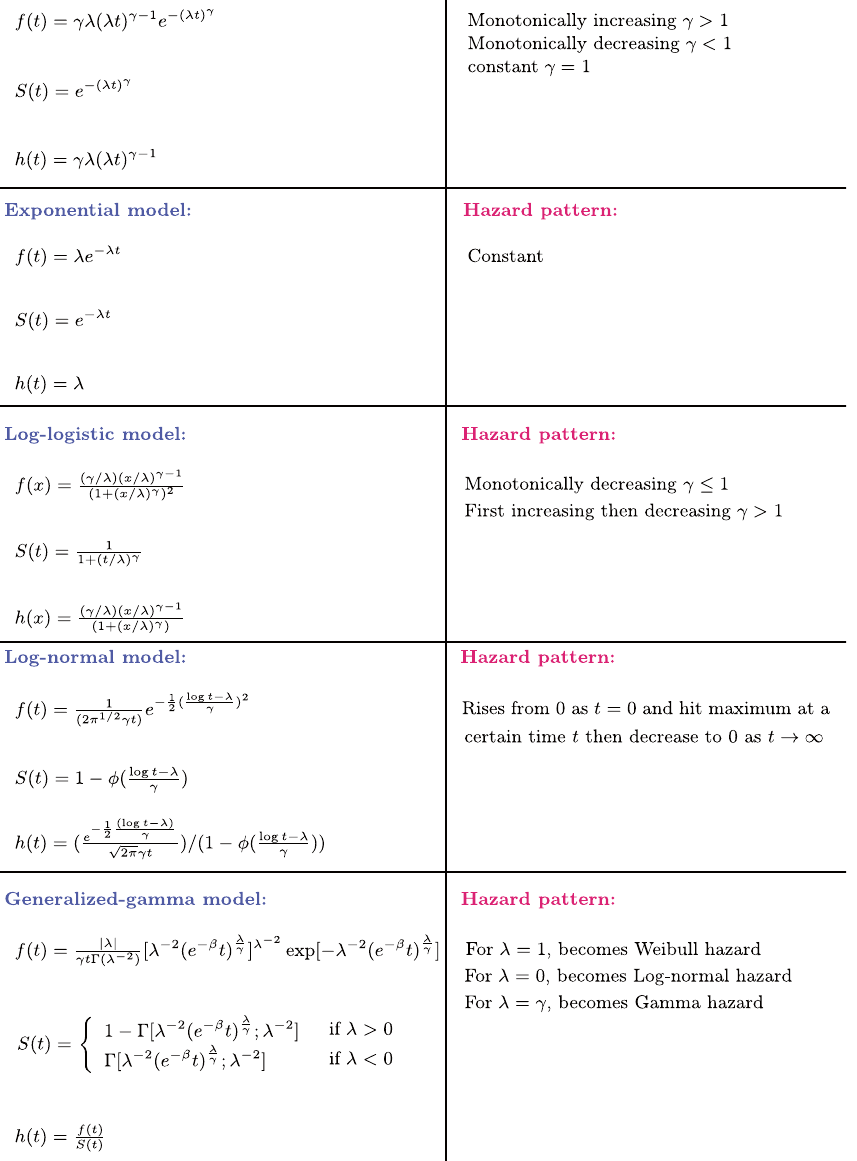
Figure 1. Overview of five parametric models used for our analysis. The left-hand-side provides information about the functional form of the survival density f , survival function S and the hazard rate h and the right-hand- side summarizes the resulting hazard-shape of the corresponding